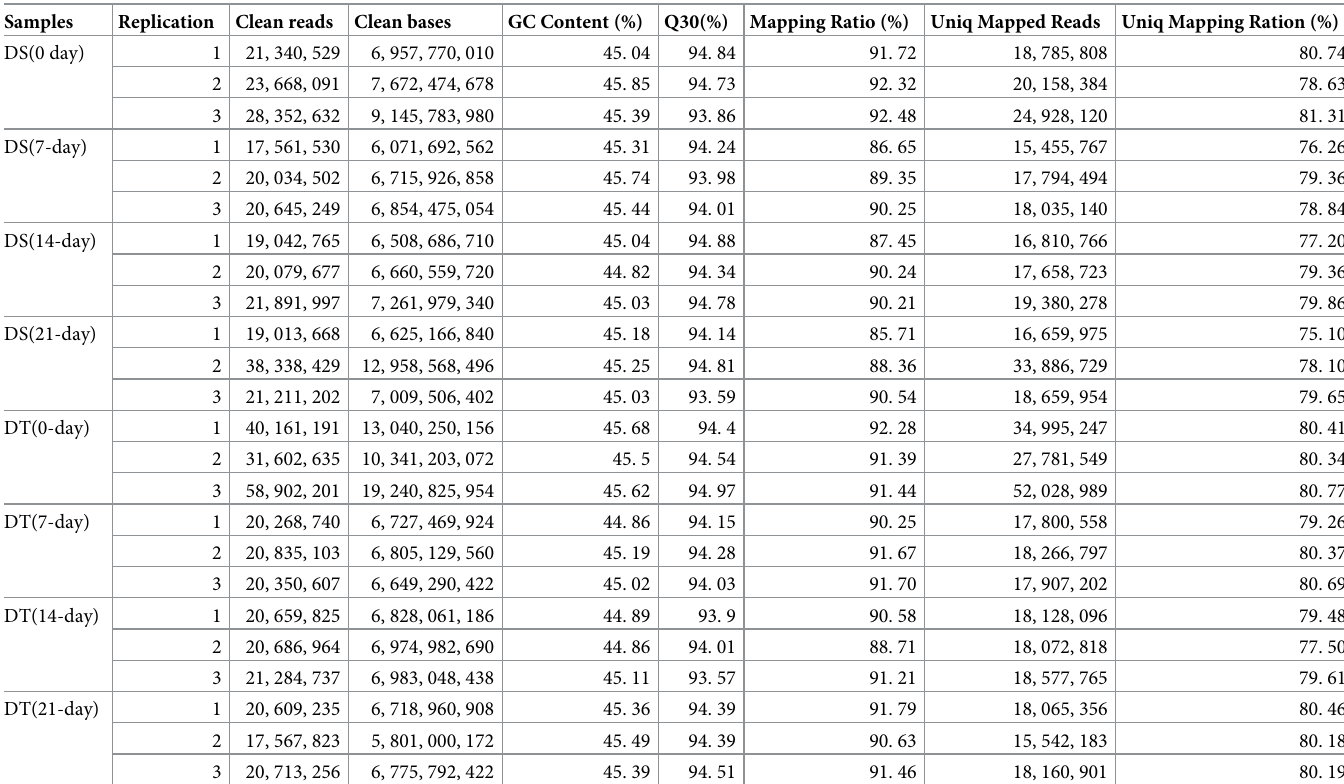
Table 1. Summary of the sequence data from RNA sequencing. Samples Replication Clean reads Clean bases